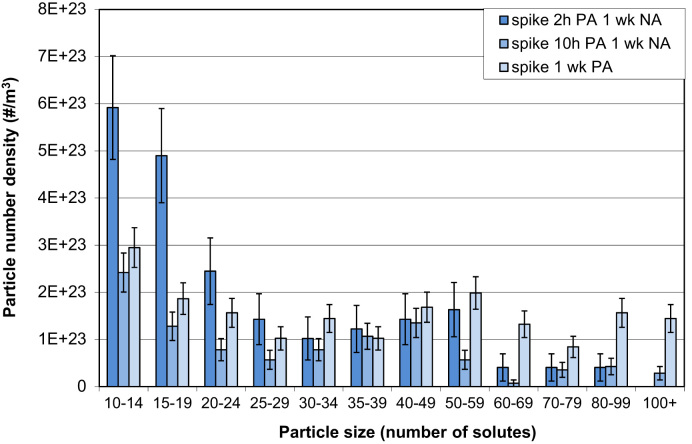
Particle number densities for different particle size ranges after a spike and 2 or 10 h or 1 week PA as measured by LAR-3DAP. A Nmin of 10 was used for particle analysis.